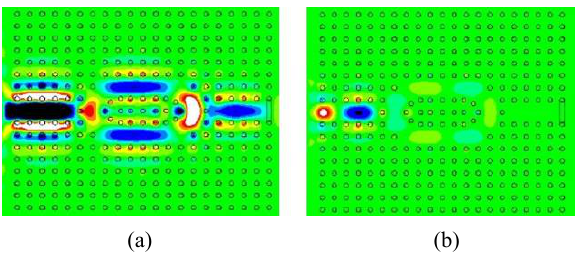
Fig. 5 Field distribution of the proposed bio sensor at (a) ON resonance (  = 1590 nm) and (b) OFF resonance (  = 1600 nm).